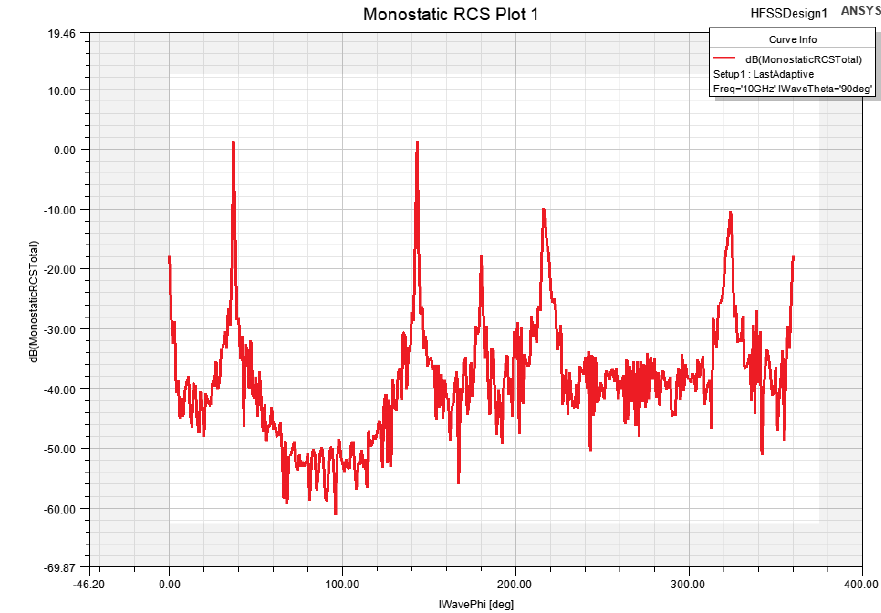
Figure 10. Simulation of RCS Linear Plot